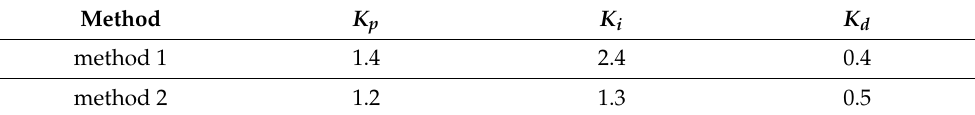
Table 2. PID controller gain values.